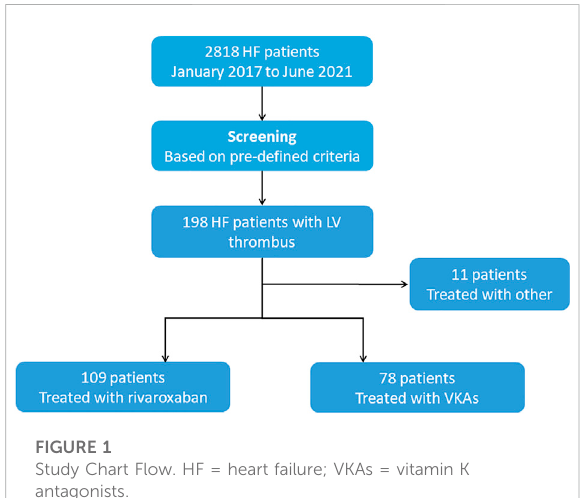
FIGURE 1 Study Chart Flow. HF = heart failure; VKAs = vitamin K